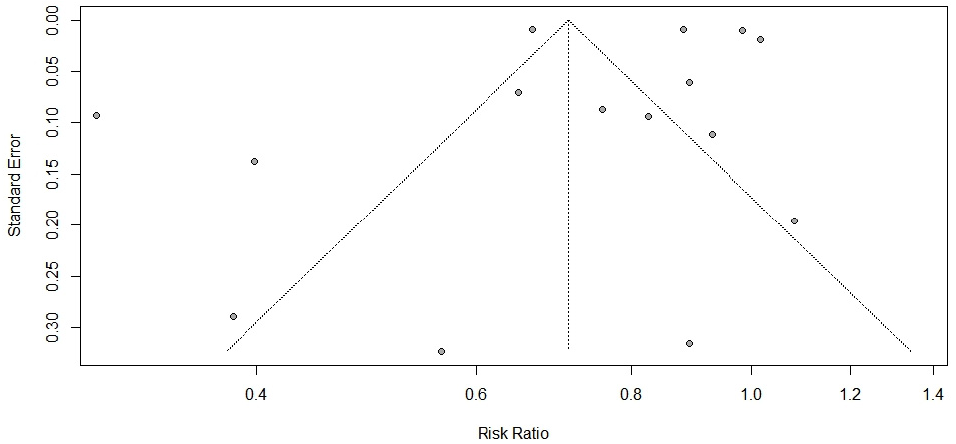
Figure 3. Funnel Figure 3. Funnel plot.